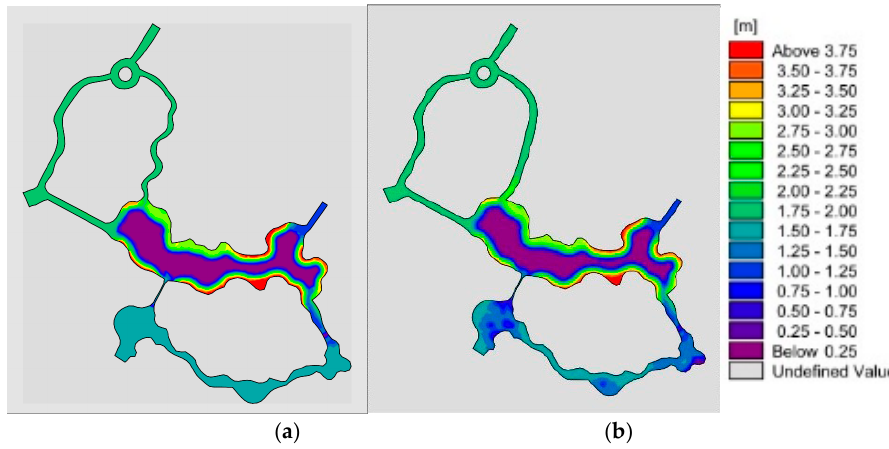
Figure 4. ( a ) The original planning of “bilateral” river elevation, ( b ) recommended “bilateral” river elevation.